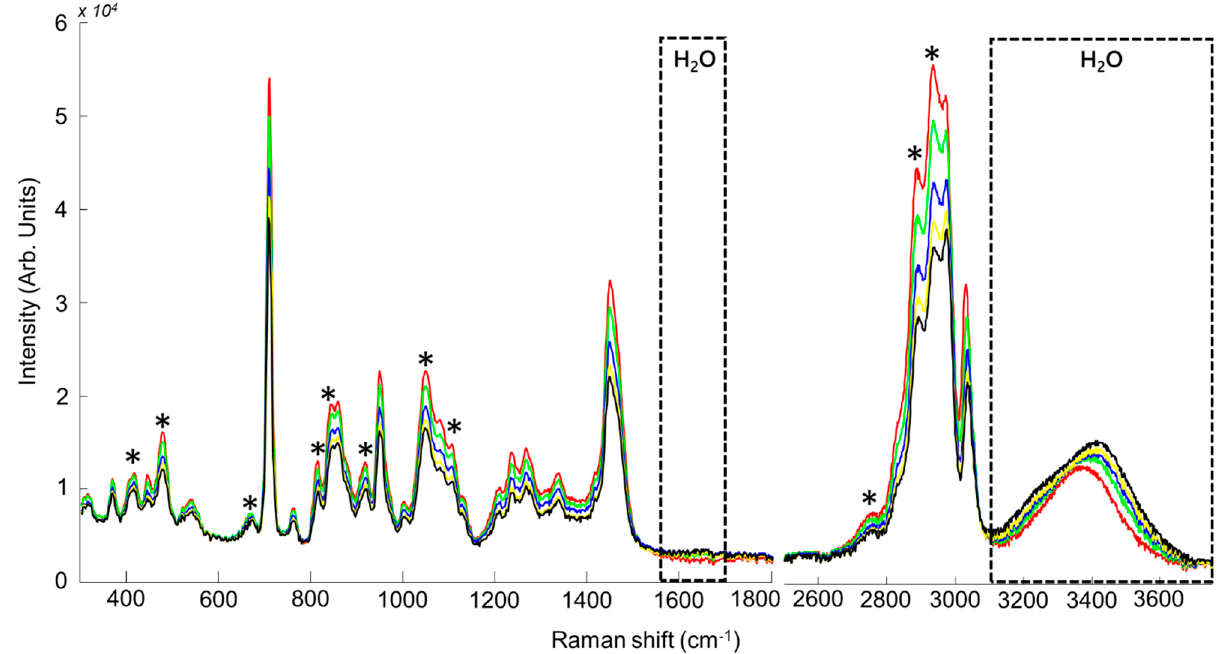
Figure 2. Mean Raman spectra for CCG samples. Concentrations for water are respectively 0% (red), 9.1% (green), 16.68% (blue), 23.08% (yellow), and 28.56% (black). * Indicates bands corresponding to glycerol. The dotted boxes indicate the positions of H 2 O features.